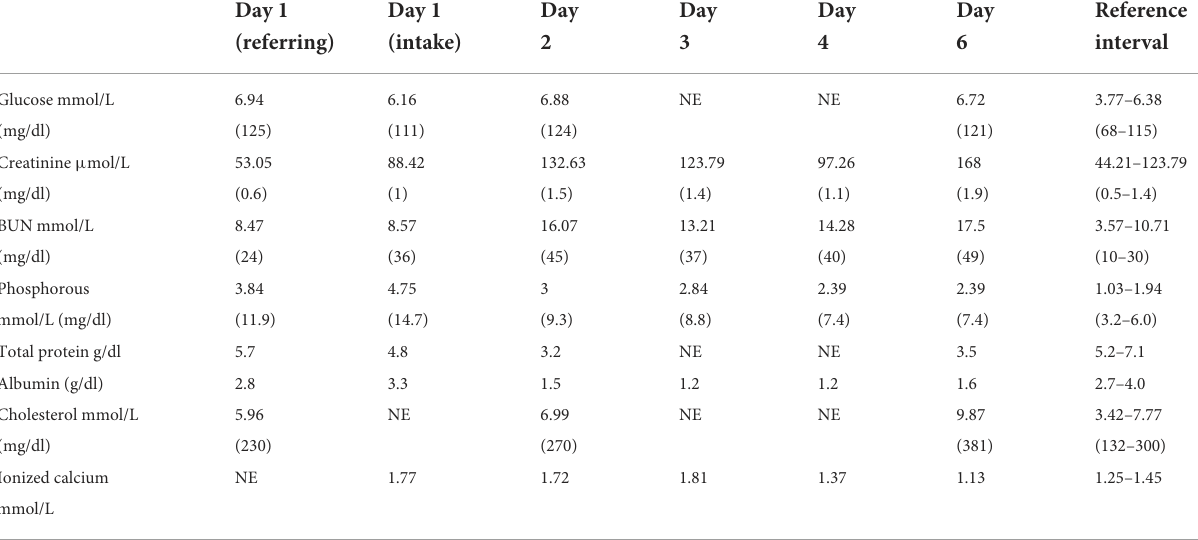
TABLE 1 Summary of pertinent serum chemistry